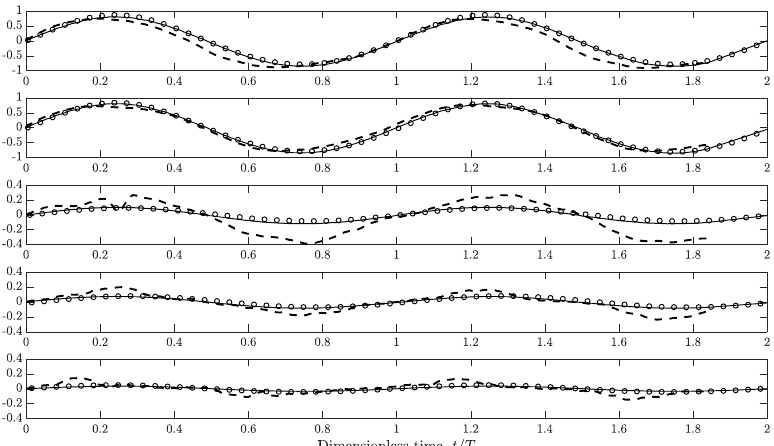
Figure 7. Time histories of horizontal velocity, u , at five different elevations. The velocity is normal- ized by the characteristic wave-induced velocity, u 0 = a 0 ( 2 π / T ) . The first and the second panels show the results at 0.04 and 0.01 m above the initial water–mud interface, respectively. The remaining three panels, from top to bottom, plot the velocity at 0.025, 0.06, and 0.09 m below the interface. Circle: present numerical results. Dashed line: laboratory data [76]. Solid line: existing analytical solutions [68]. In this example, T = 1.3 s, a 0 = 0.025 m, d = 0.3 m, d m = 0.11 m, ν m = 0.03 m 2 /s, ρ m = 1294.7 kg/m 3 , and u 0 = 0.12 m/s. Records of experimental data were slightly less than two wave